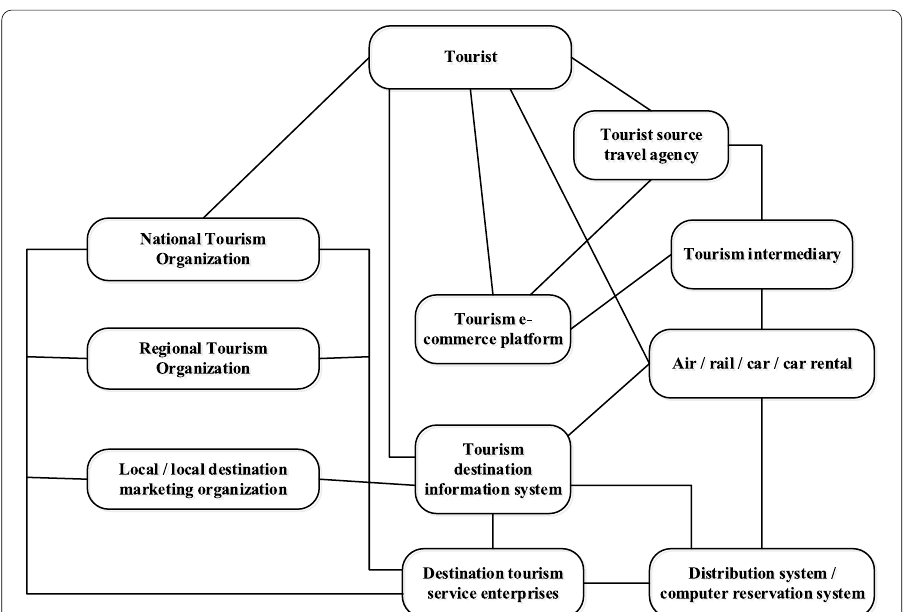
Fig. 7 Value chain of tourism industry under e-commerce